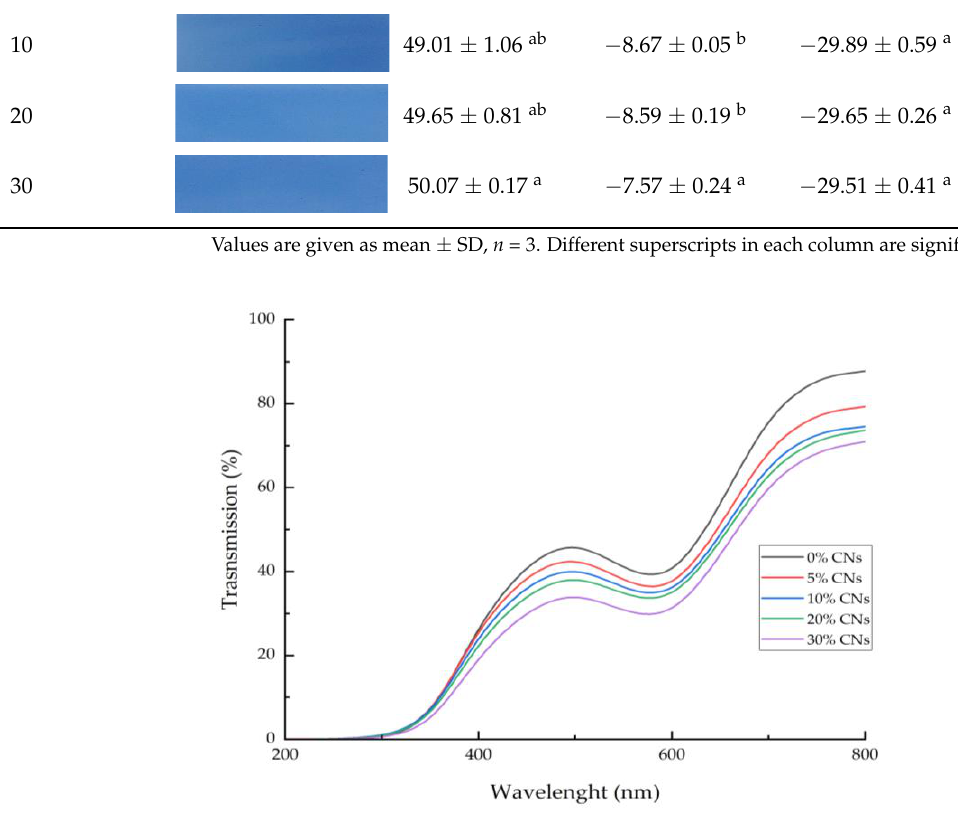
Figure 1. Light transmission of smart bilayer films incorporating different concentrations of cellulose nanosphere